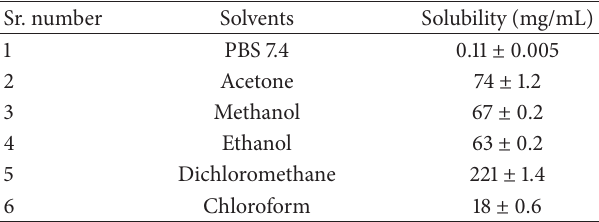
Table 2: Solubility of CLR in different solvents ( 𝑛 = 3